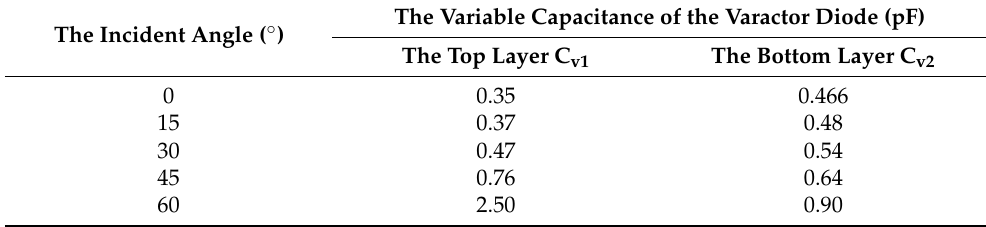
Table 1. The variable capacitance of varactor diodes with the incident angle from 0 ◦ to 60 ◦ . The Variable Capacitance of the Varactor Diode (pF) The Incident Angle ( ◦ ) The Top Layer C